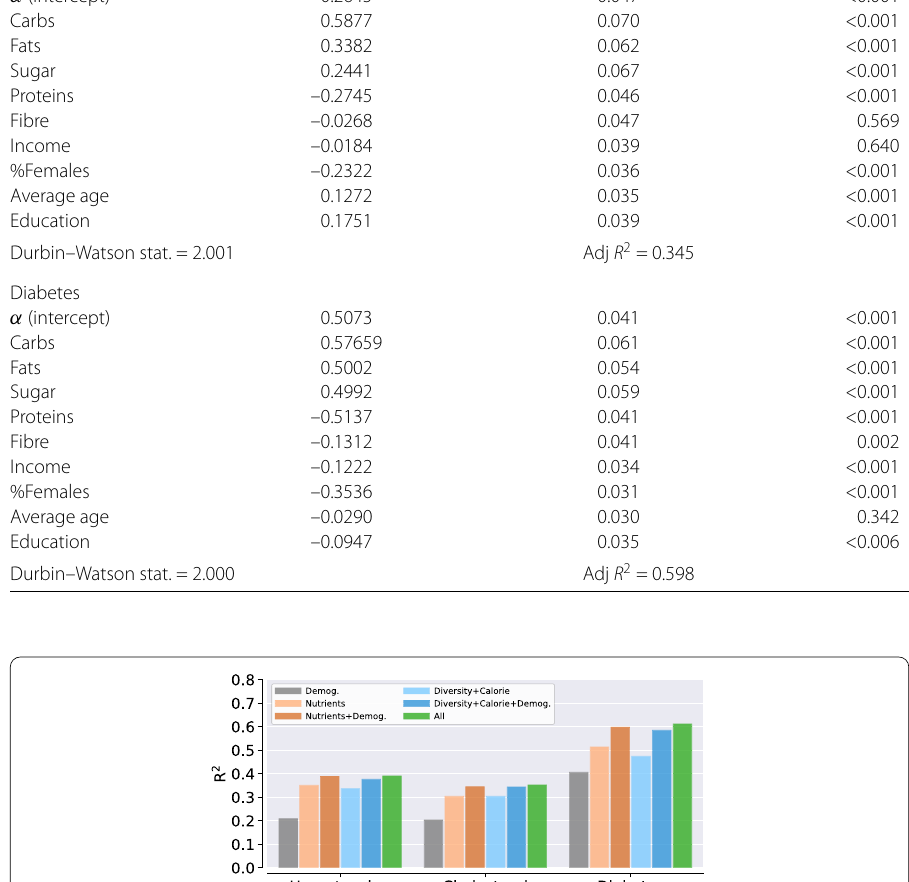
classification problem as a binary classification: the goal is to identify areas that fall into the top and bottom quartiles of each of the three diseases (higher scores corresponded to higher presence of a disease). As such, we define the response variable y i as 0, if area i is in the first quartile of the disease distribution; and as 1, if it is in the last